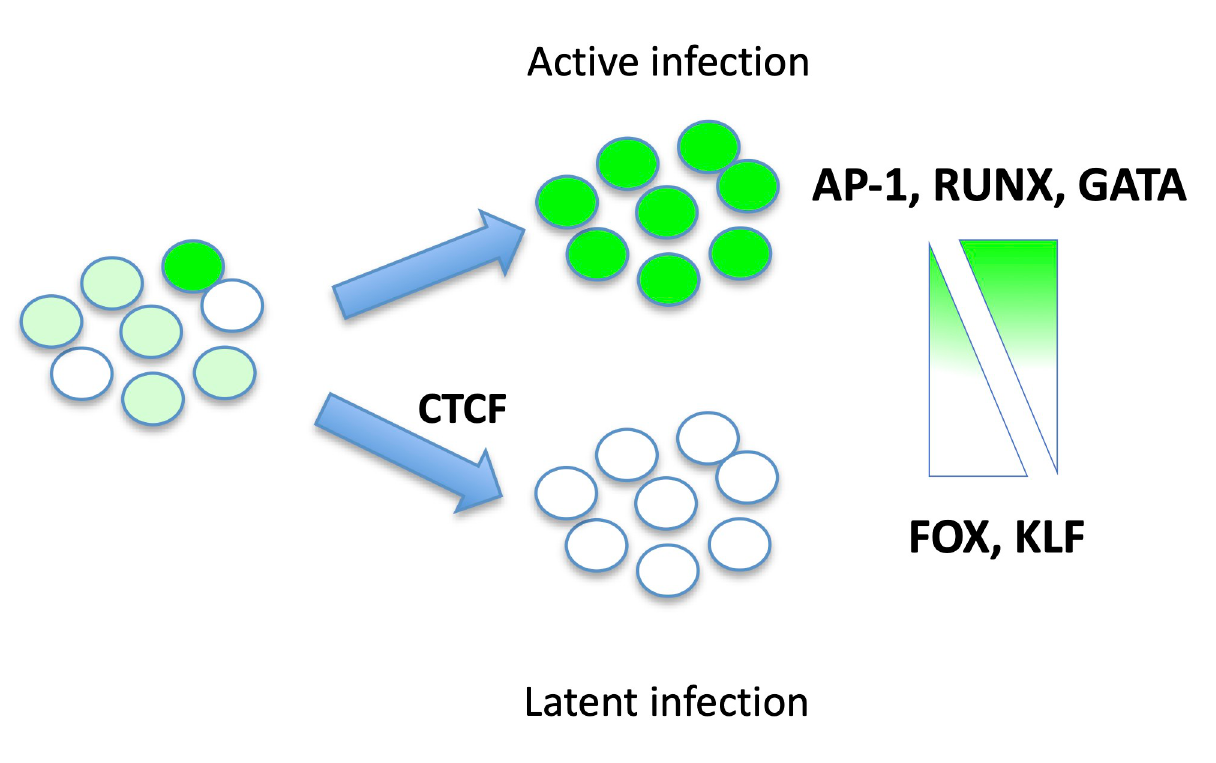
Fig 8. Schematic model of transcription factor activity and HIV latency. HIV-GFP infected cells exhibit variegated levels of transcriptional silencing. Comparison of actively infected (green) and latently infected (white) CD4 T cells reveals latency associated TF activity. Latently infected cells have elevated Forkhead (FOX) and Kruppel-like factor (KLF) TF activity, and reduced AP-1, RUNX and GATA TF activity relative to actively infected cells. The chromatin insulator CTCF promotes HIV latency.